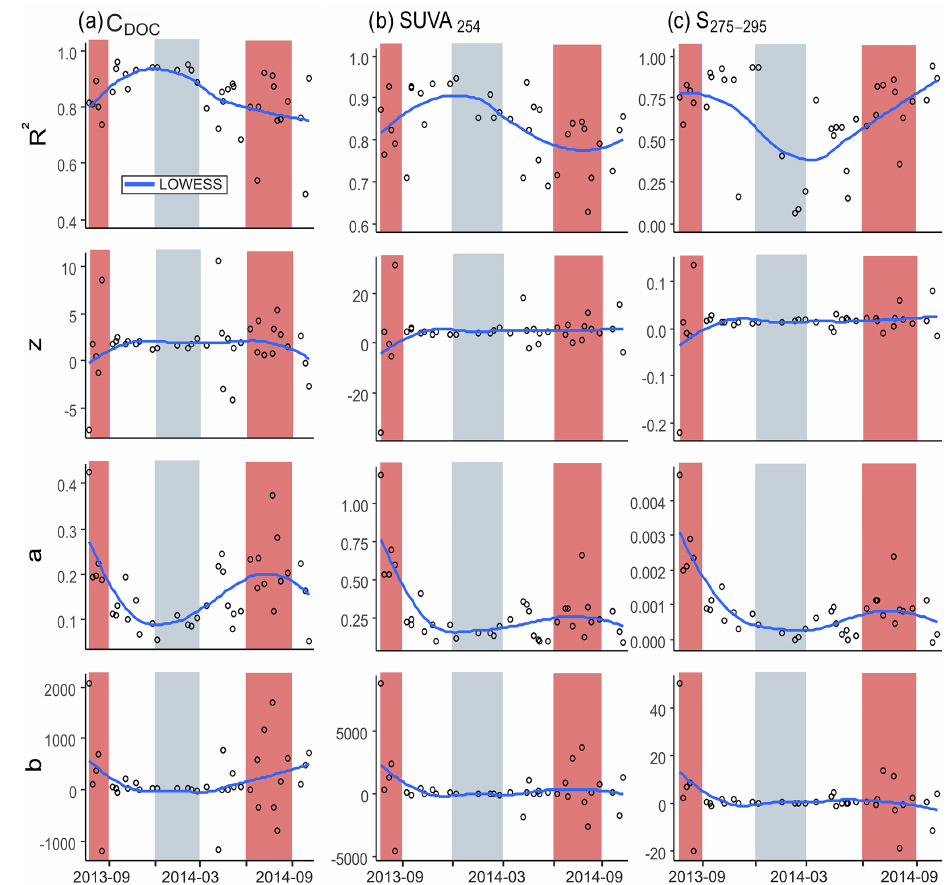
Figure 3. R 2 , intercept z , and regression coefficients a and b of the model predictors log ( Q hf ) and Q b in Eq. (2) of all 38 events plotted against time. The headings in the top of the figure indicate which variable was represented by Y in Eq. (2). Blue lines indicate the locally weighted scatterplot smoothing (LOWESS), background colors indicate seasons (grey: winter; red: summer; white: autumn and spring). Note the different scales of the y